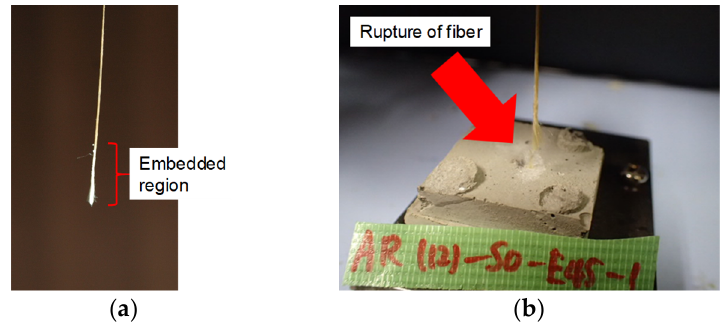
Figure 5. Examples of tested fiber and specimen after loading: ( a ) Pulled out fiber; ( b ) Rupture of fiber.